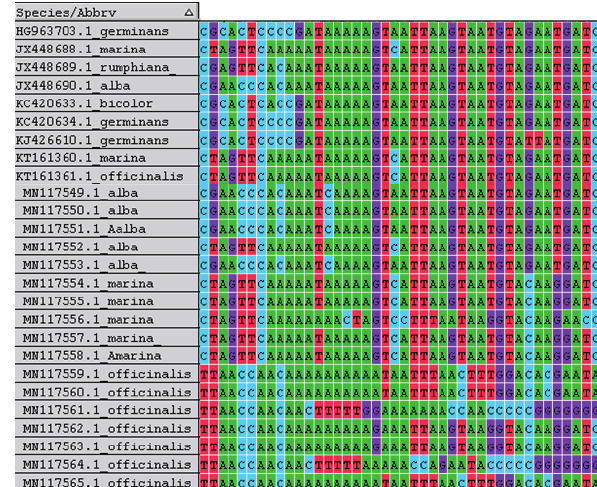
Figure 7. TrnHG-psbA sequences in Avicennia species, showing mini-barcodes which differentiate the studied taxa.